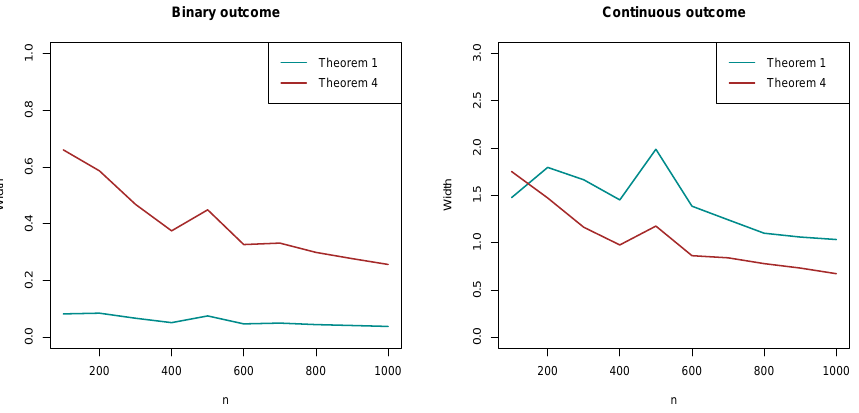
Figure 2. Width of the error bounds with the increasing of sample sizes (using estimated